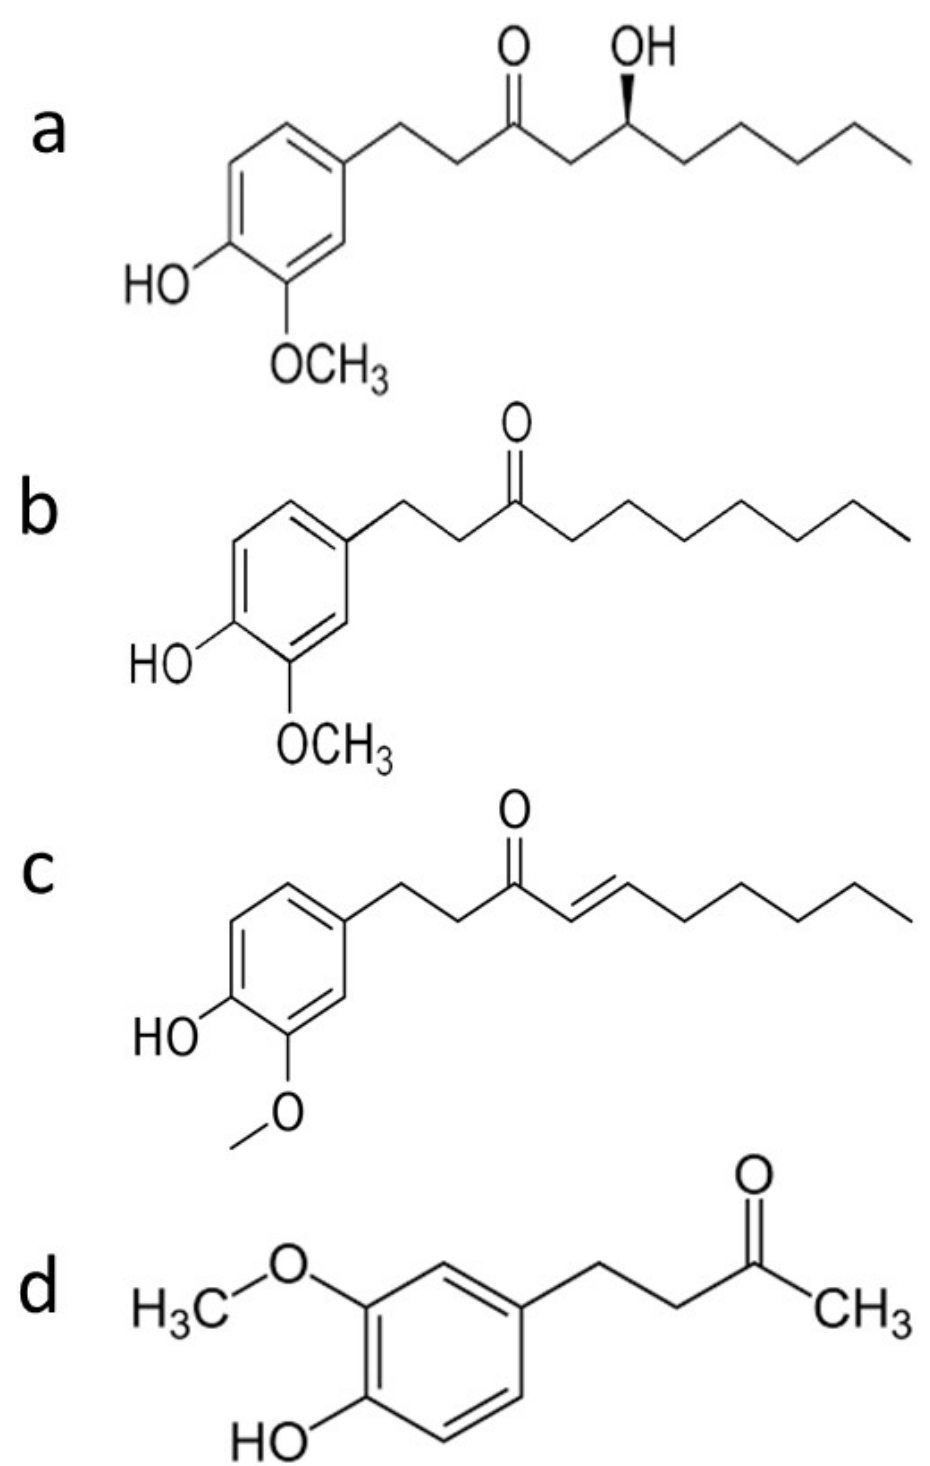
Figure 1. Chemical structure of main phenolic compounds of ginger: ( a ) 6-gingerol (1-[4’-hydroxy-3’-methoxyphenyl]-5- hydroxy-3-decanone), ( b ) 6-paradol, ( c ) 6-shogaol, and ( d )